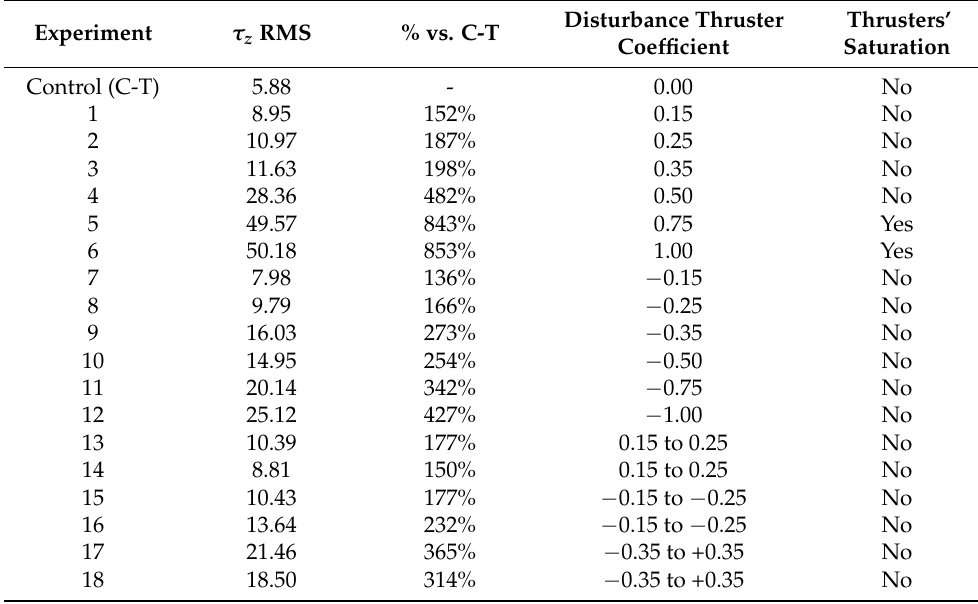
Table 5. Experimental results for the τ z control signal in the station-keeping phase. Experiment τ z RMS % vs. C-T